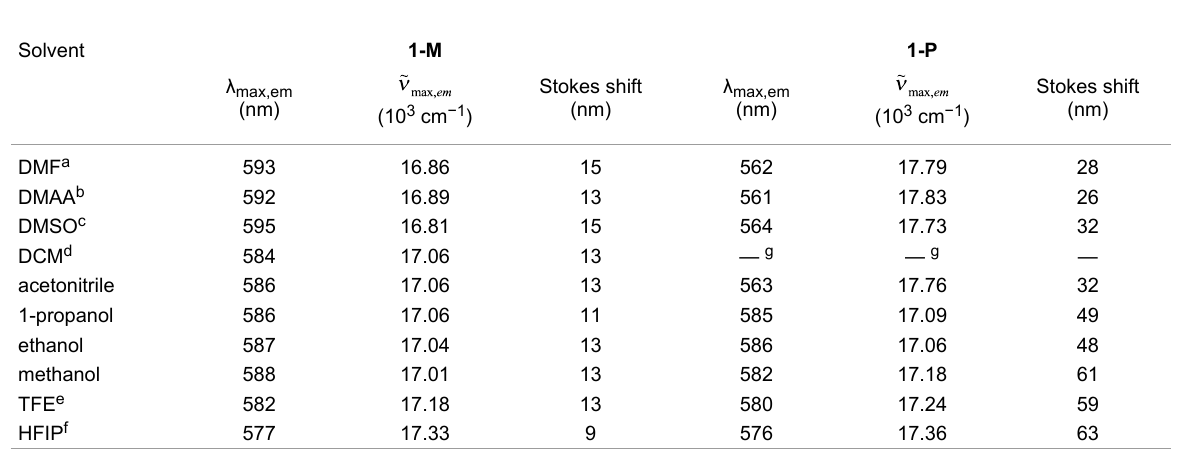
Table 4: Fluorescence emission maxima